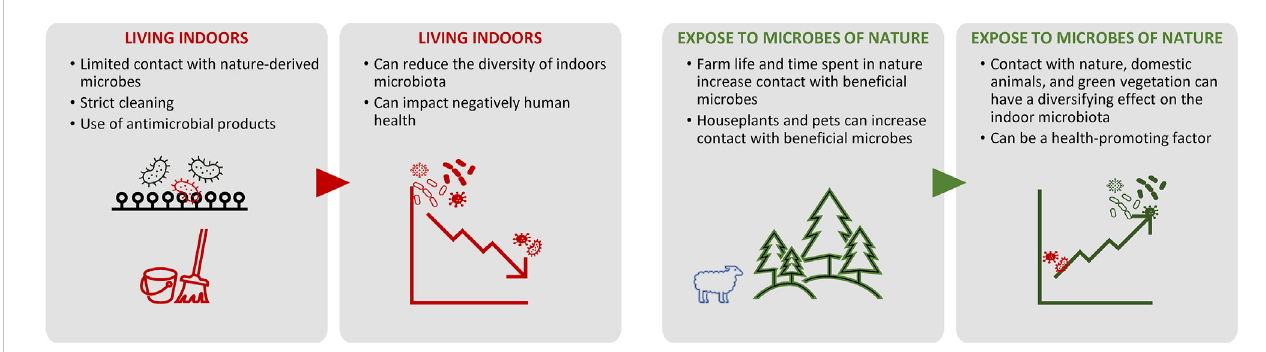
FIGURE 4 Living indoors, limited contact with natural microbes, strict cleaning with hygiene products, and the use of antimicrobial products can reduce the diversity of indoor microbiota and that of the inhabitants, impacting human health. The diversity of indoor microbiota increases when residents anddomestic animals bring microbes from nature indoors and when green vegetation and domestic animals are found in the habitat. Farm life and time spent in nature are signi fi cant health-promoting